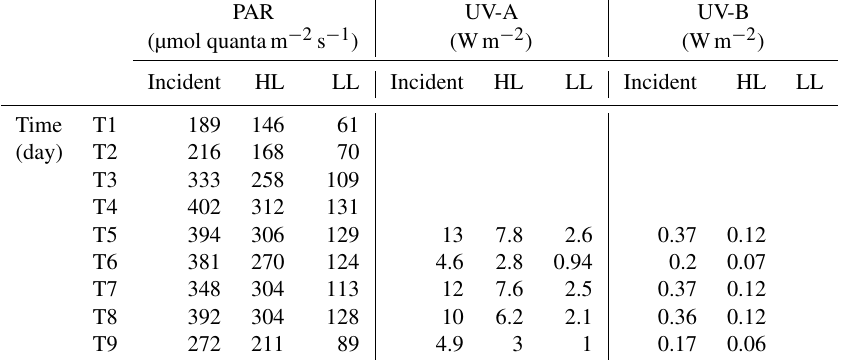
Table 2. Photosynthetically active radiation (PAR), ultraviolet A radiation (UVA), and ultraviolet B radiation (UVB) measured during the 9-day microcosm experiment. Values are shown for the incident irradiance and the estimated irradiance under the high light (HL) and low light (LL) treatments (i.e. values corrected for the transmission through the incubation bags). PAR values were averaged over a day whereas UVA and UVB were measured each day around noon between T5 and T9 only due to instrument dysfunction during the first 4 days. PAR UV-A UV-B (µmol quantam − 2 s − 1